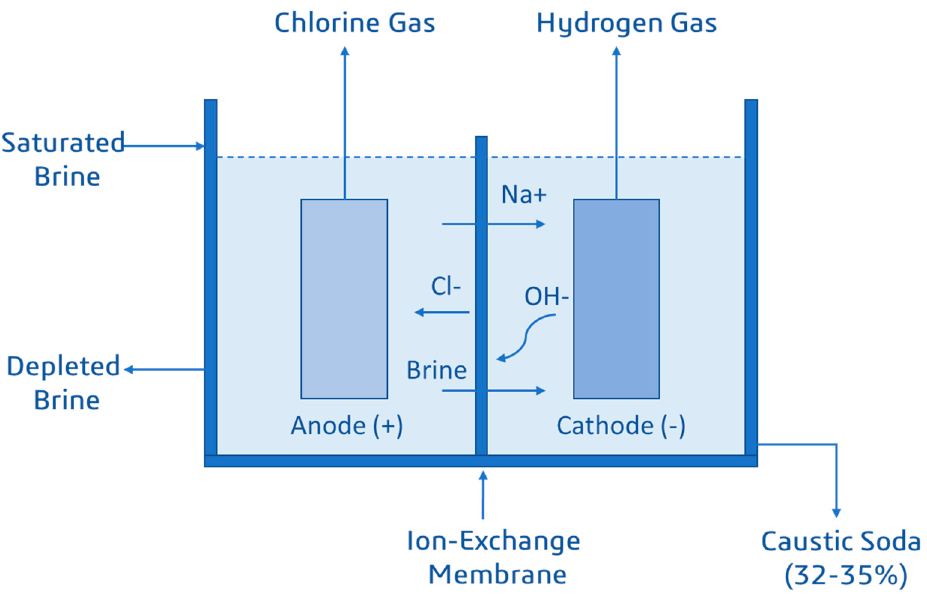
Figure 5. Membrane cell techniques (cell level)